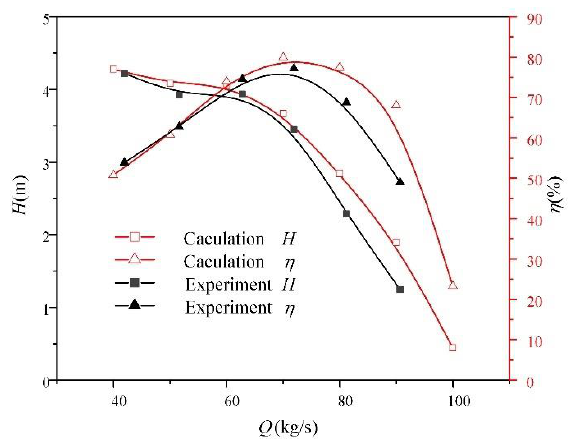
Figure 4. Comparison of pump head and efficiency between experiment and simulation.